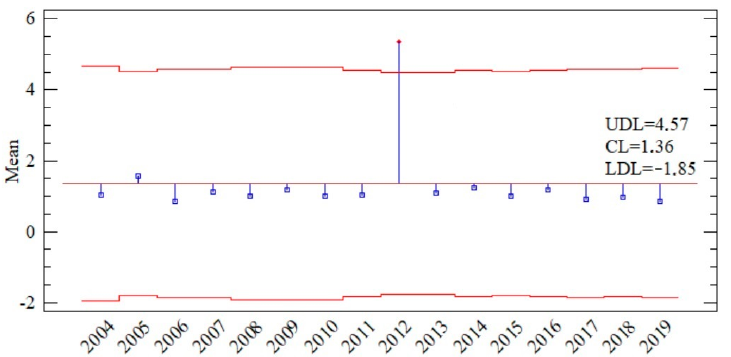
Figure 2. ANOM analysis of the development of the RCR index in the period 2004–2019.